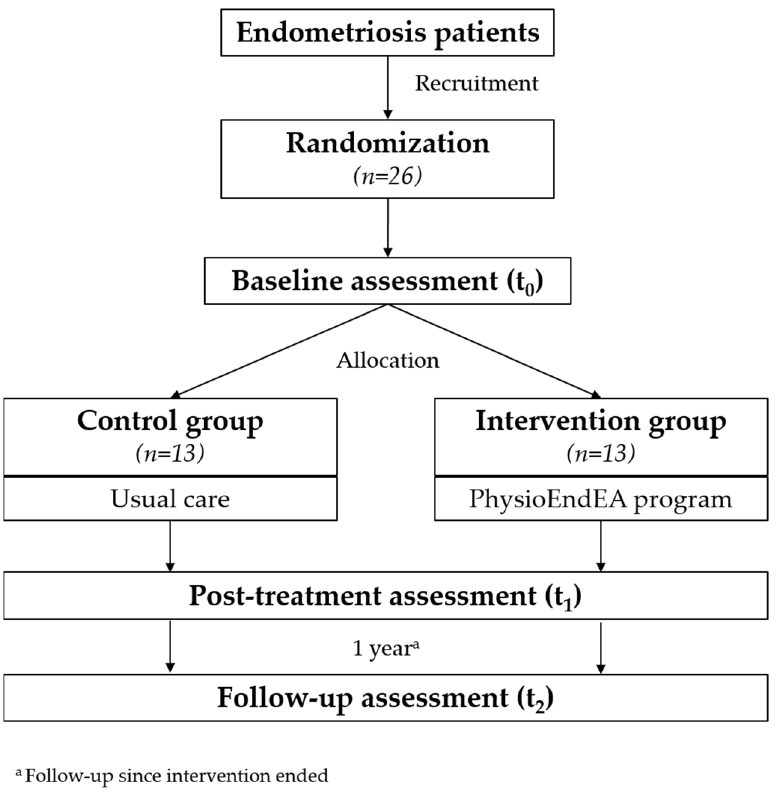
Figure 1. Flow diagram of participant recruitment during the trial according to SPIRIT.